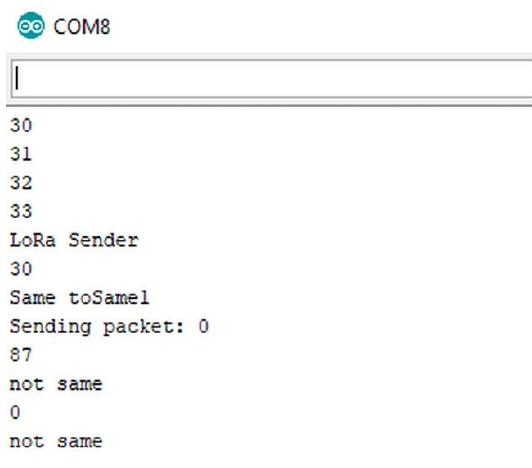
Fig. 7. LoRa sender output display on the Arduino IDE The values given on the first four lines are the last two digits of the 8 digit RFID tag IDs stored in the Arduino database. When the read tag ID matches with the database, message packets are transmitted otherwise it is ignored.